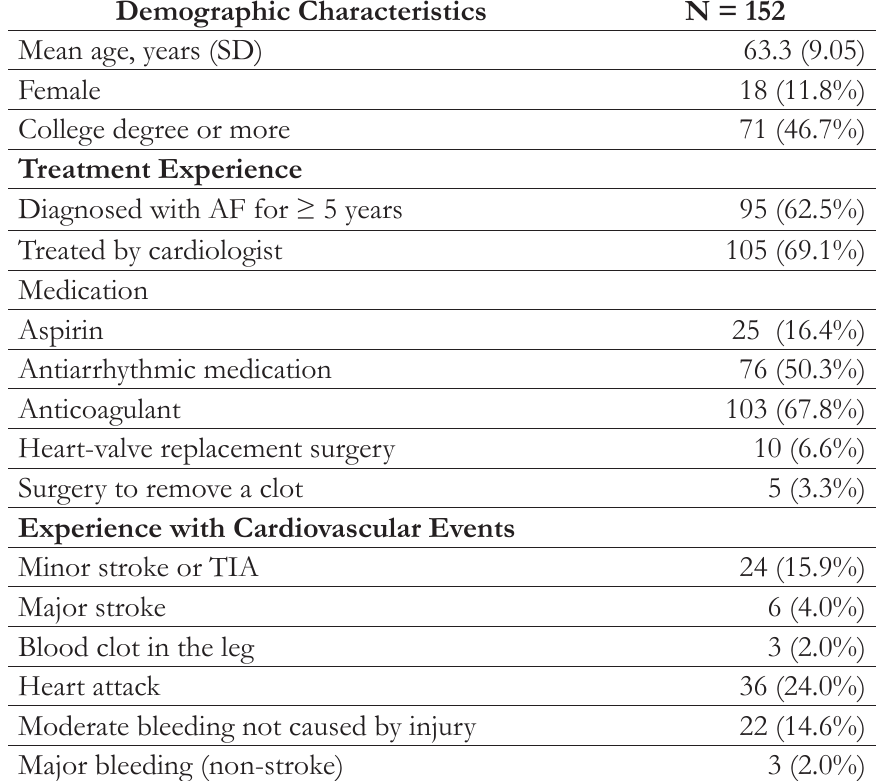
Table 3. Sample Characteristics: Patients (n = 152)